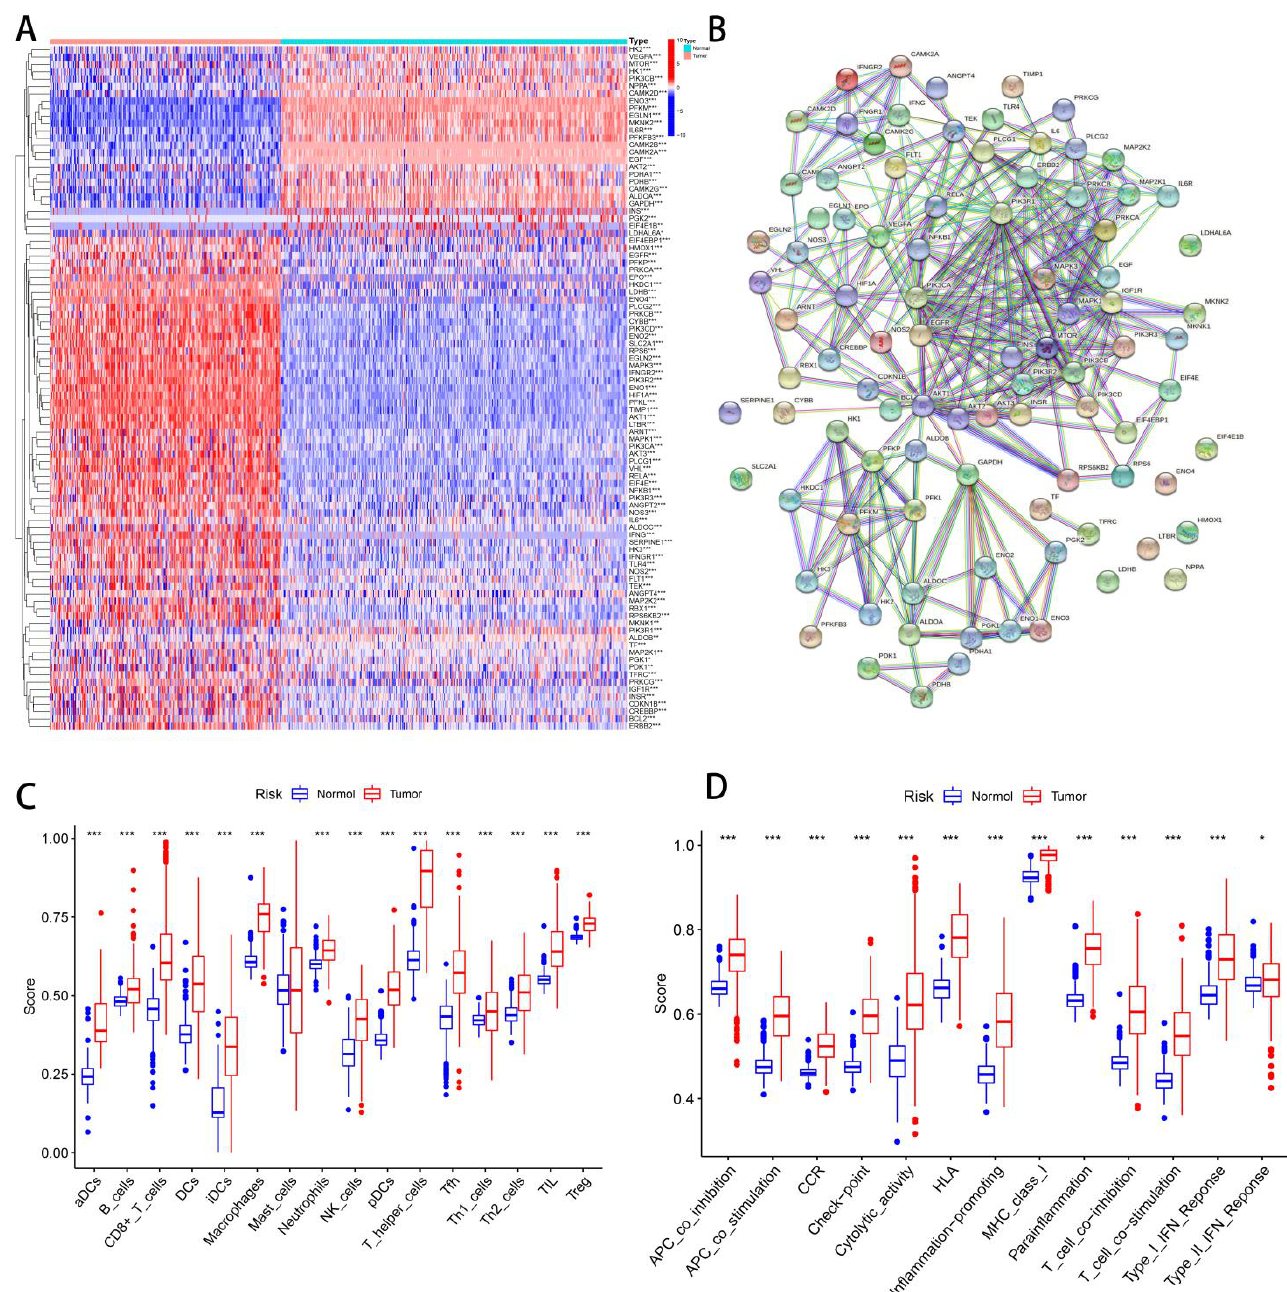
Figure 2. Differentiate hypoxia/TME between normal and tumor tissues. ( A ) Heatmap of hypoxia-related DEGs in normal and tumor tissues. ( B ) PPI network of 94 DEGs. ( C ) Differential analysis of immune cells between normal tissues and tumors. ( D ) Difference analysis of immune function between normal tissues and tumors. ns, p ≥ 0.05; *, 0.01 ≤ p < 0.05; **, 0.001 ≤ p < 0.01; ***, 0.0001 ≤ p < 0.001.